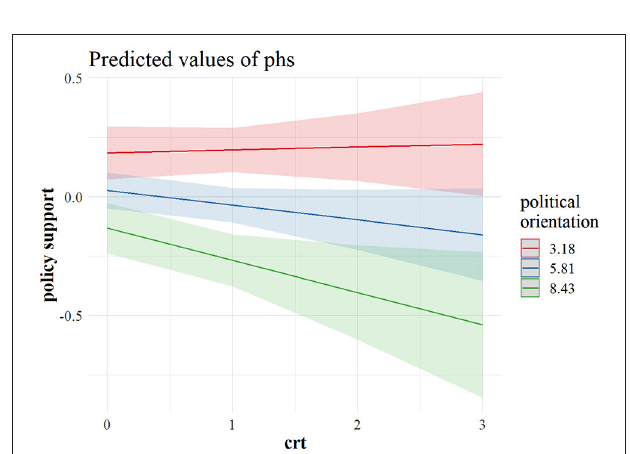
FIGURE 6 | Marginal predicted values for policy support from a model interacting CRT and political orientation in the US sample ( n = 905). The predictor values for left (3.18), centrist (5.81), and right (8.43) political orientation are ± 1 SD . CRT values (0–3) indicate the number of correct responses. phs, support for restrictive COVID-19 policies; crt, cognitive reflection.